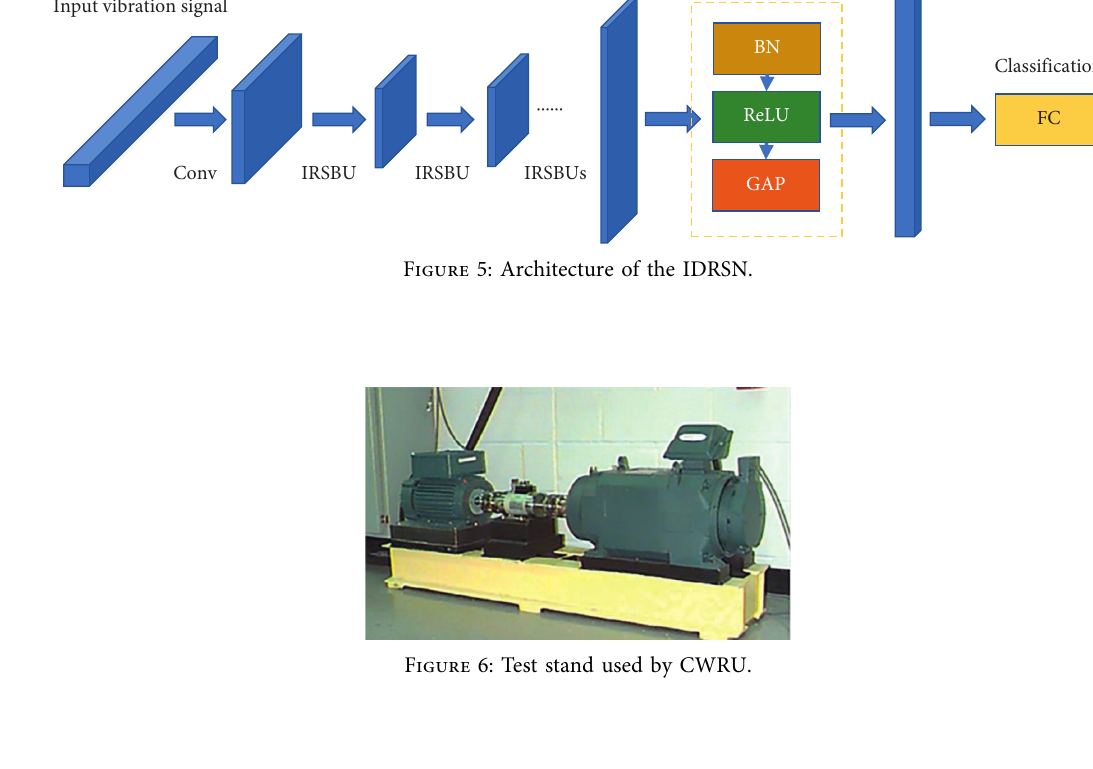
Table 1: The description of the experimental datasets.